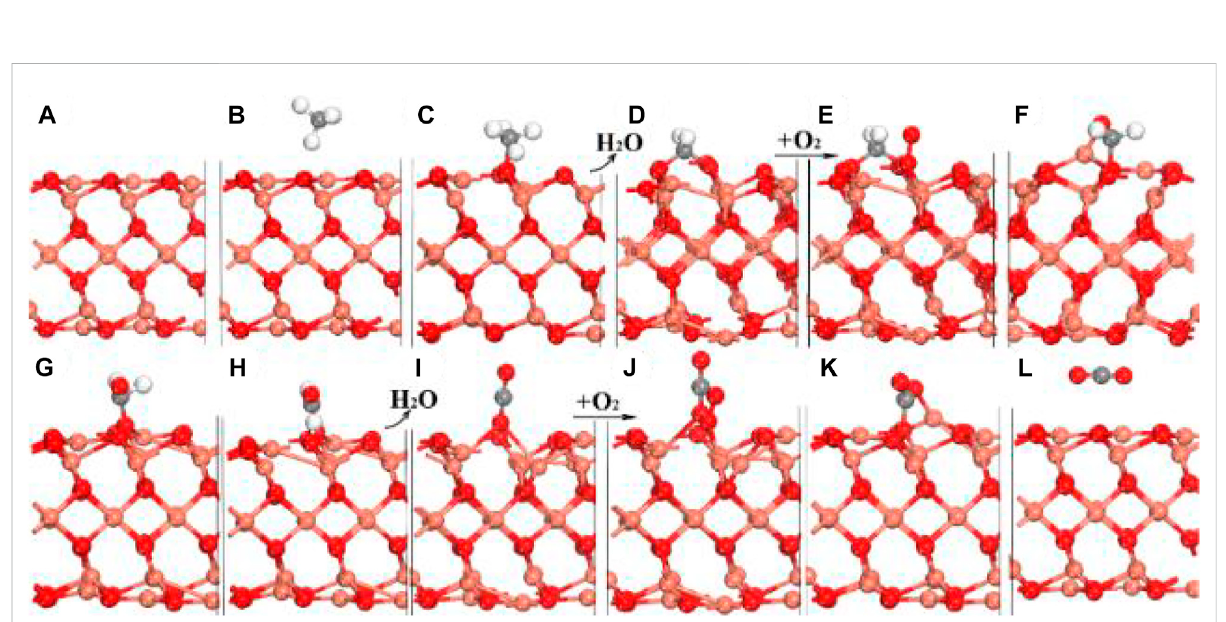
FIGURE 12 (A) Clean (001); (B) CH 4 physical adsorption; (C) CH 4 dissociative adsorption; (D) CH 2 * with oxygen vacancy (OV) presented; (E) CH 2 * with O 2 adsorbed; (F) CH 2 * rotating and interacting with O 2 *; (G) transition state (TS) state COH 2 *; (H) CHO* + H*; (I) CO* with OV presented after releasing one H 2 O; (J) CO* with O 2 adsorbed; (K) TS for O transfer to CO*; (L) CO 2 physical adsorbed. Cu, O, C, and H are shown as rose-carmine, red, grey and white spheres, respectively. Reprinted with permission from Kong et al. (2018). Copyright (2018)